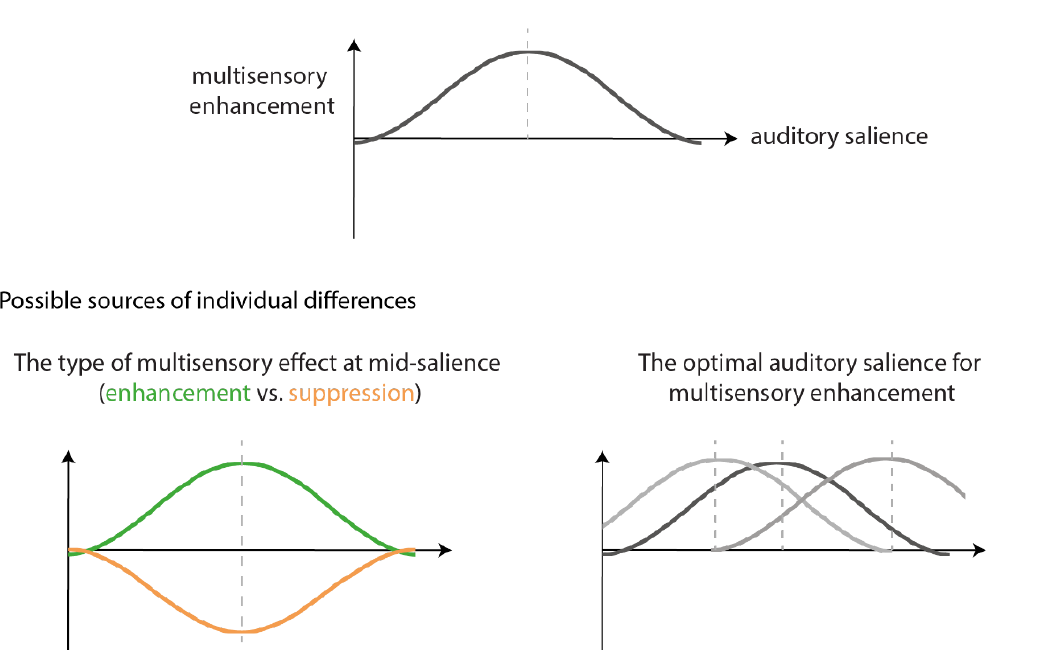
Figure 3. ( A ) Illustration of hypothetical data showing the expected results where multisensory enhancement peaks at mid-auditory salience, reflecting the interaction between temporal phase coherence and auditory salience. ( B ) Illustration of possible sources of individual differences which could arise from the type of multisensory e ff ects, enhancement or suppression, at mid-auditory salience (left), or the optimal auditory salience required for multisensory enhancement (right).